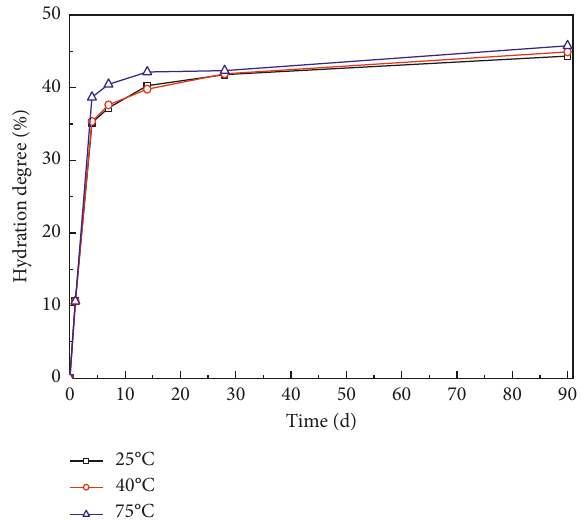
Figure 3: The hydration degree of UHPFRC in the sealed